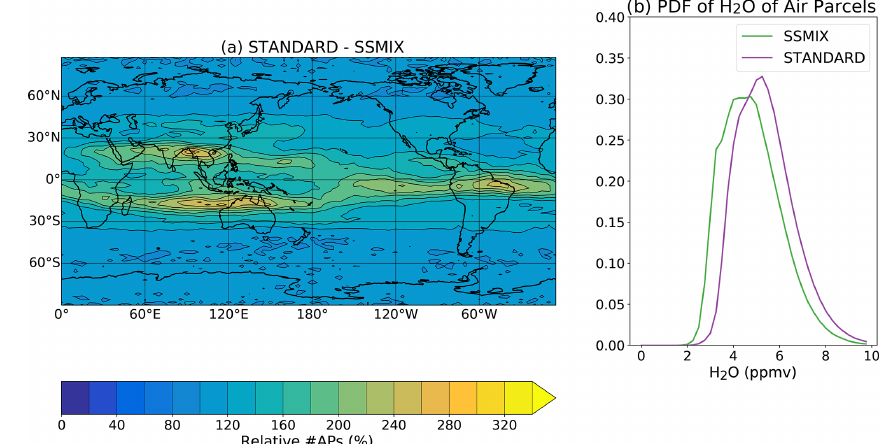
Figure 9. (a) Distribution of the relative number of air parcels simulated in STANDARD with respect to SSMIX during JJA for 2007–2016. (b) Normalized PDF of the water vapour of air parcels encountered during JJA (2007–2016) over the Asian Monsoon region (20–40 ◦ N, 40–140 ◦ E) for SSMIX and